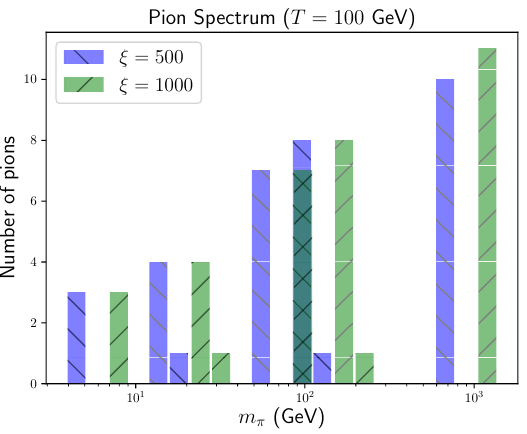
Figure 2 . Spectrum of pion masses for two choices of (cid:24) , with v h corresponding to the Higgs VEV at T = 100